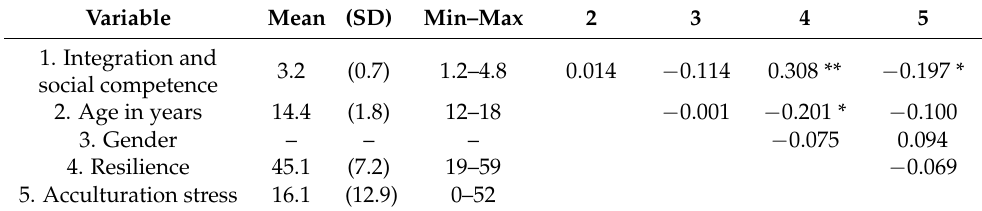
Table 3. Means, standard deviations, and correlations between the study variables in the sec- ondary